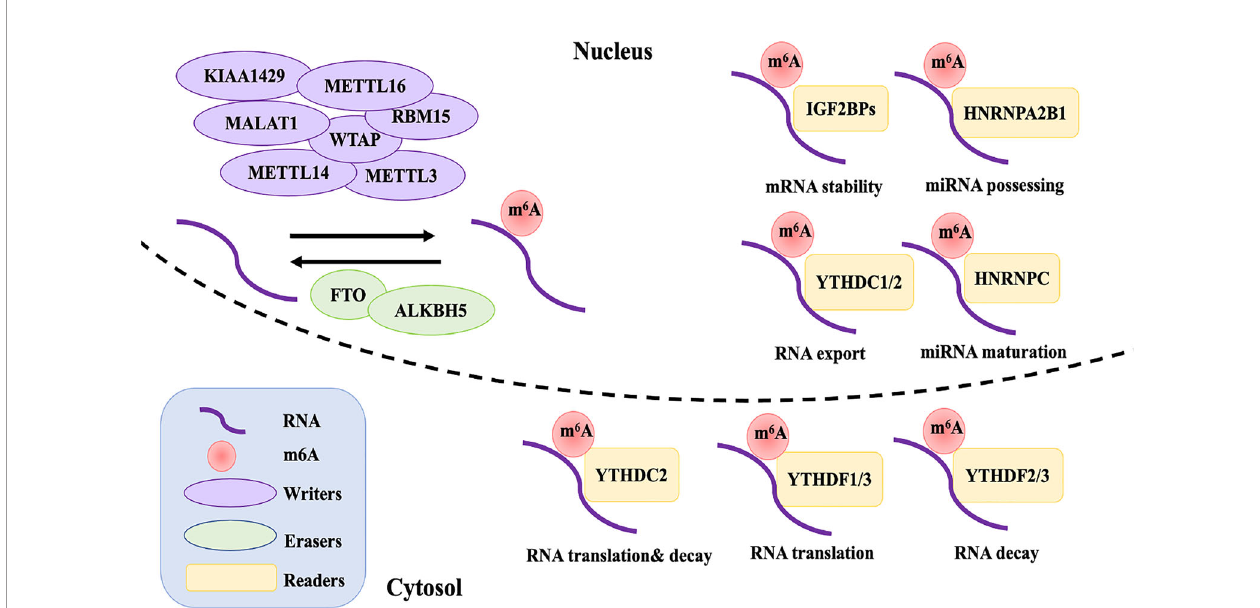
FIGURE 1 | The reversible of m6A RNA modi fi cation is regulated by “ writers ” , “ erasers ” , and “ readers ” . Writers including METTL3, METTL14, WTAP, RMB15, KIAA1429, ZC3H13, and METTL16 interact with a special sequence of RRACH in mRNA that produces catalytic activity to add m6A methylation. The demethylations are performed by erasers FTO and ALKBH5. The differently biological functions of m6A in RNA metabolism are recognized by reader proteins from the YT521-B homology YTH domain (YTHDF1-3 and YTHDC1, 2), IGF2BPs (including IGF2BP1-3), and HNRNPC and